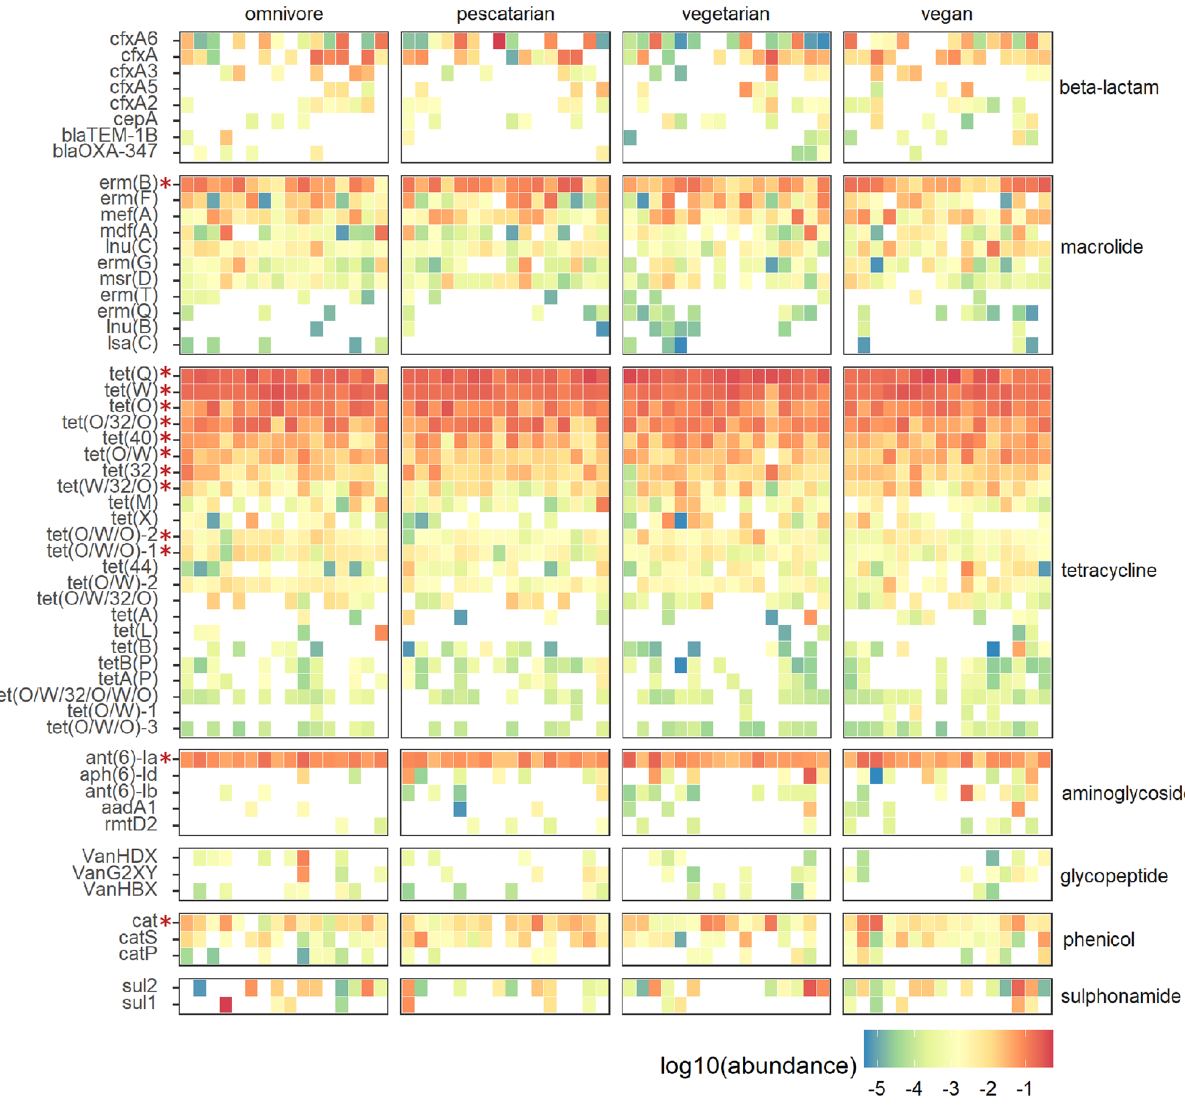
Figure 4. Antibiotic resistance gene distribution in the gut resistome as detected by ResCap. Each column denotes a participant, clustered in columns according to diet group. Rows are categorized by antibiotic resistance gene (ARG) classes. ARGs present at least in 10% of the participants are shown. ARGs that are present in the resistome of at least 95% of the participants are indicated by the